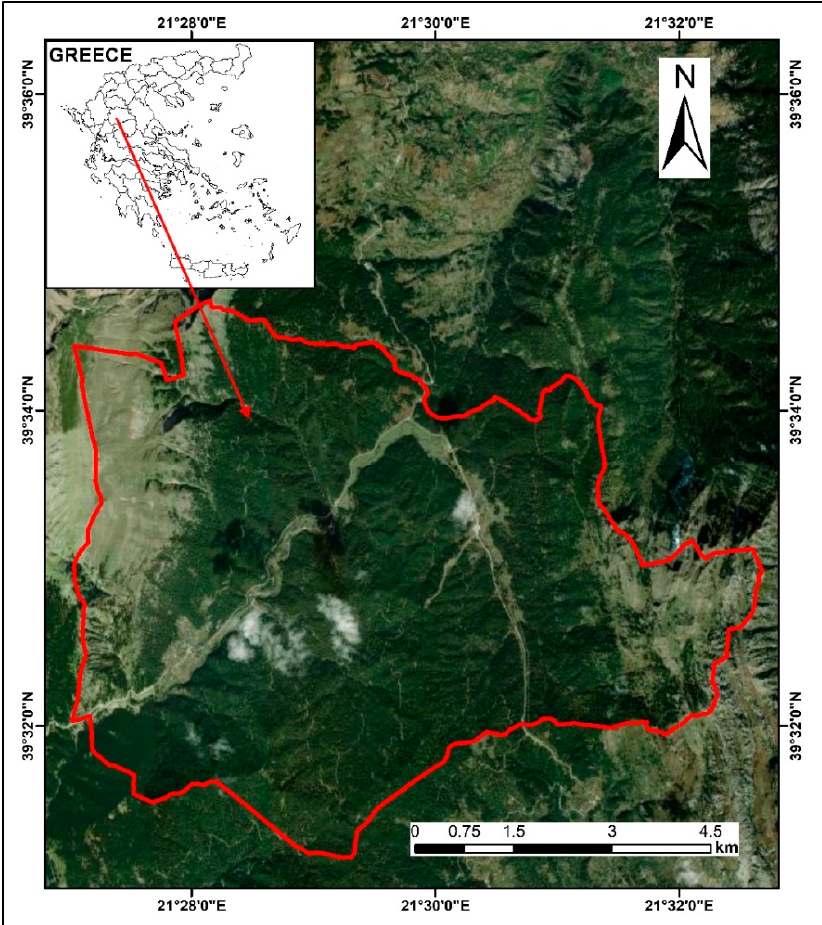
Figure 1. Study area. The red line presents the borders of Pertouli University Forest. Table 1. Sampling area and site characteristics .